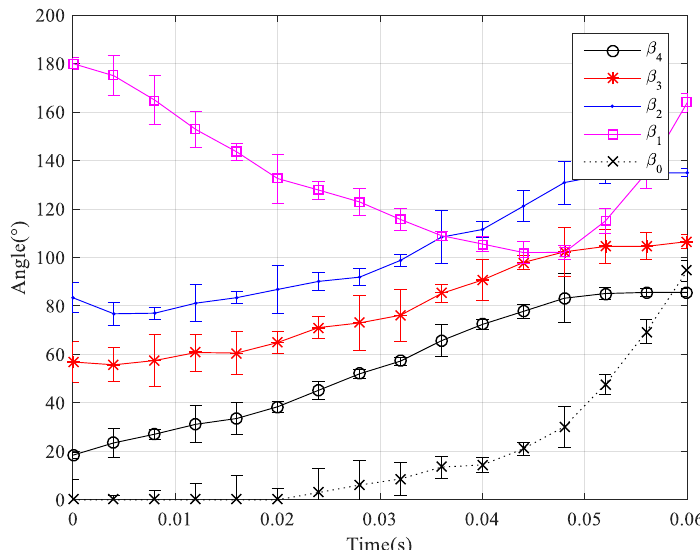
Figure 8. Angles of each joint of the flying squirrel’s hind limbs when jumping for progress.